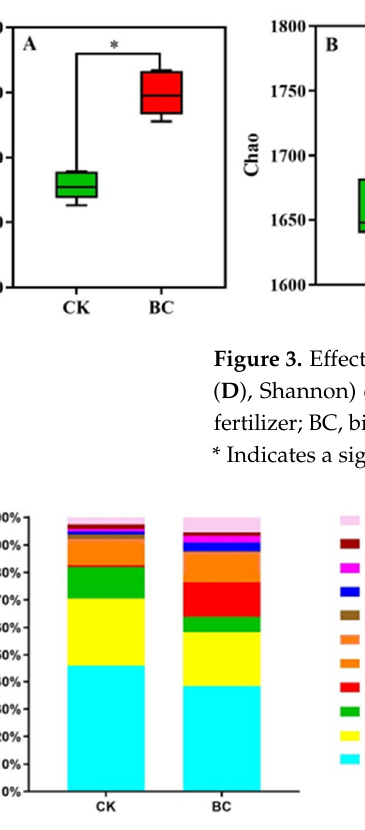
Figure 4. Effect of biochar on relative abundance of bacterial phyla ( A ) and class ( B ). CK, conven- tional fertilizer; BC, biochar with conventional fertilizer.